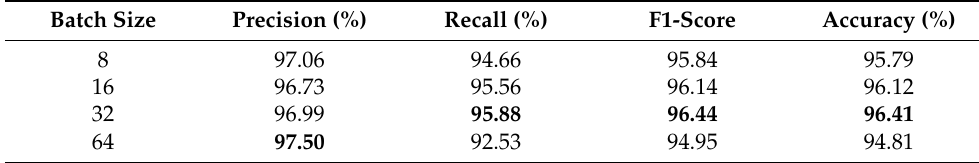
Table 3. Model’s performance for various batch sizes with SGD optimizer and original